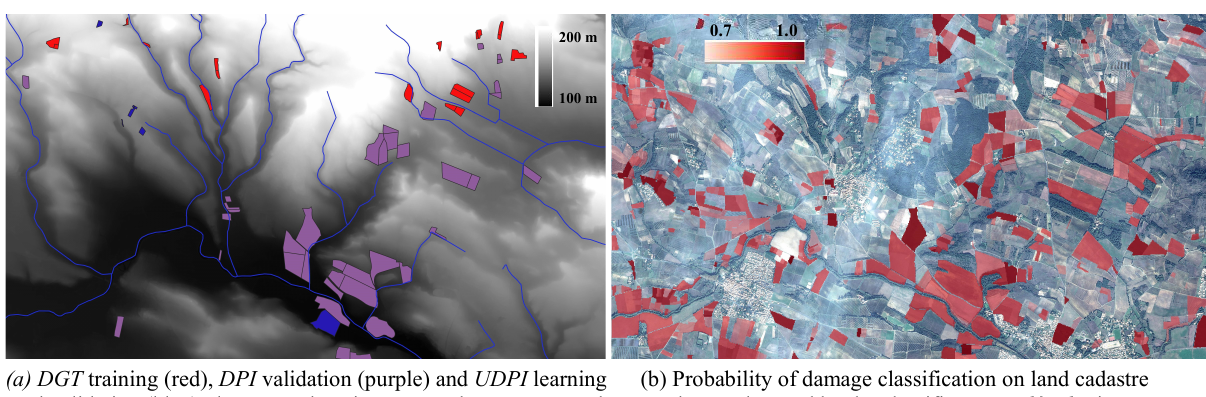
Figure 8. Close-up of the output map displaying the probability of damage classification (on untrained plots) by Gaussian Process classifier over Pléiades image from 2018/11/03, based on: [ (𝑅𝐷 (cid:3015)(cid:3005)(cid:3023)(cid:3010) ) (cid:3046)(cid:3031)(cid:3032)(cid:3049) ; (𝑅𝐷 (cid:3020)(cid:3002)(cid:3023)(cid:3010) ) (cid:3040)(cid:3032)(cid:3028)(cid:3041) ; Land Use]